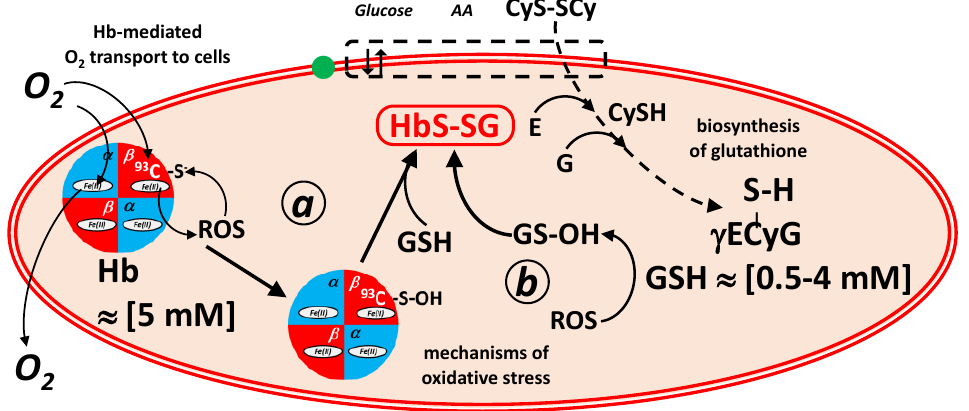
Figure 1. Formal mechanism for the generation of glutathionyl-hemoglobin by thiol exchange of glutathione disulfide with the thiol(ate) group in the side chain of one β -93-Cys residue (h-Hb structure modified from https://proteopedia.org/fgij/fg.htm?mol=3ODQ, accessed on 30 September 2022).